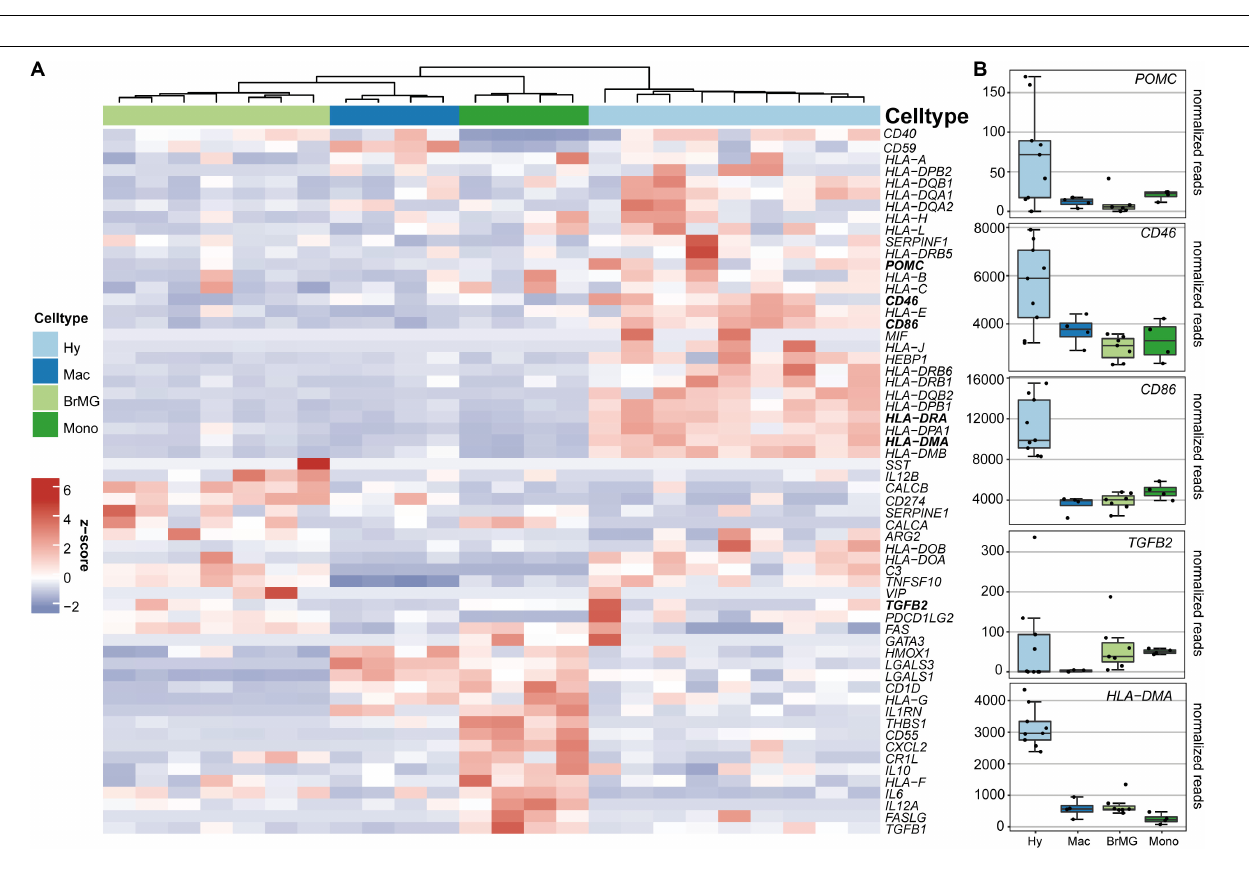
FIGURE 4 | Immunomodulatory transcripts in human hyalocytes and other myeloid cells. (A) Heatmap representing the expression pattern of 40 established immune privilege factors in hyalocytes (Hy, light blue), macrophages (Mac, dark blue), brain microglia (BrMG, light green), and blood-derived monocytes (Mono, dark green). (B) Boxplots illustrating the expression of POMC , CD46 , CD86 , TGFB2, and HLA -DMA in hyalocytes (Hy, light blue box), macrophages (Mac, dark blue box), brain microglia (BrMG, light green box), and blood-derived monocytes (Mono, dark green